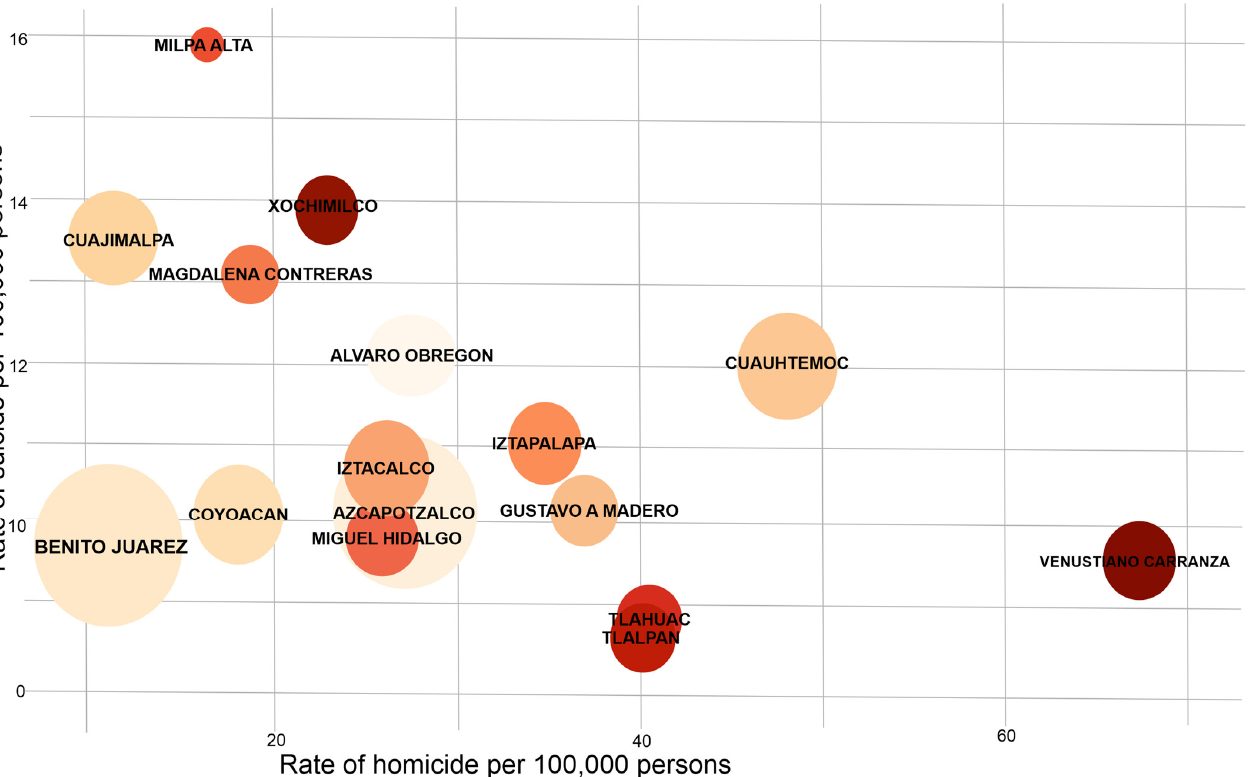
Figure 1. Comparison of homicide and suicide rates (per 100,000 inhabitants) in the general population of Mexico City in 2019, distributed by municipalities. The color is indistinct.